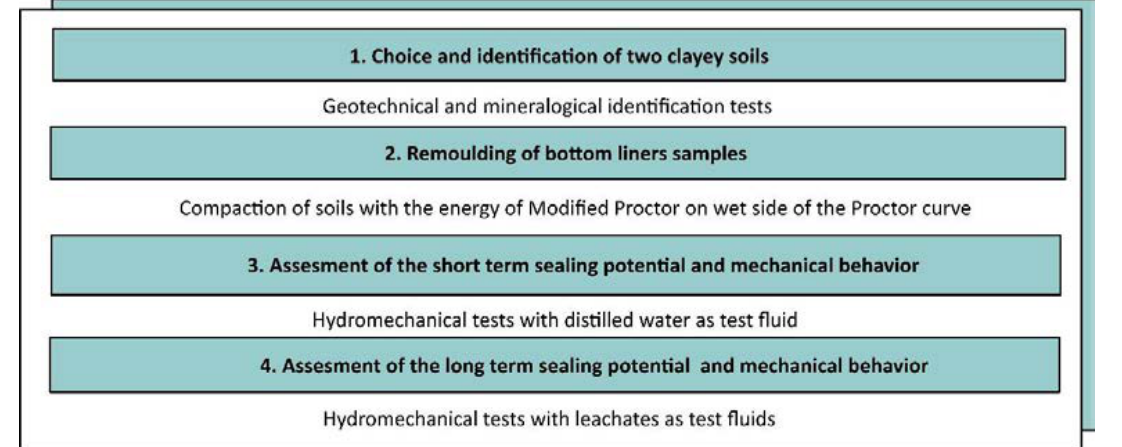
Fig. 1: Methodology of characterization of the hydro-mechanical behavior of the two clayey soils